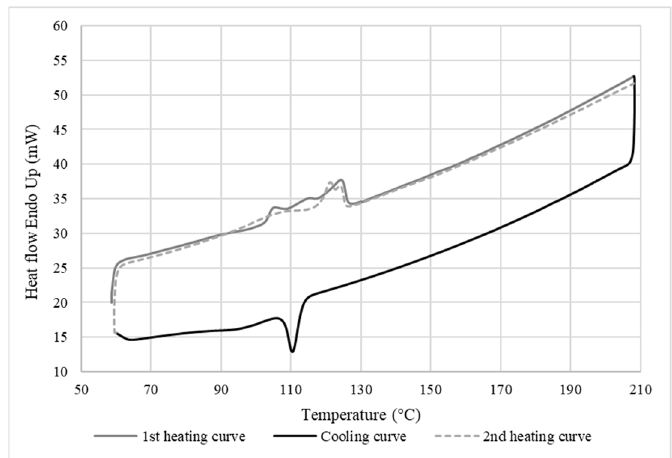
Figure 8. DSC curves of the membrane after leaching (10 °C/min).